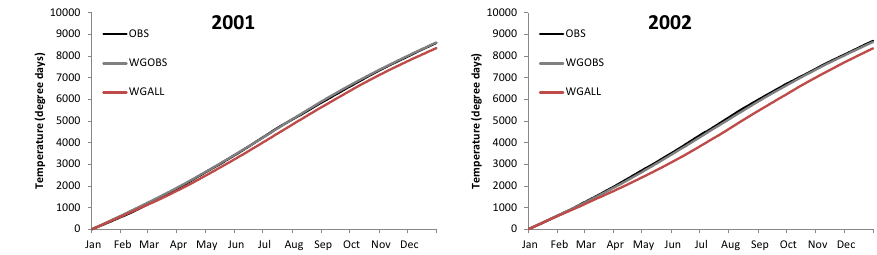
Figure 18 Observed (OBS) and generated (WGOBS, WGALL) cumulative degree day totals Fig. 17. Observed (OBS) and generated (WGOBS, WGALL) cumulative distributions of daily mean temperature (left) and precipitation for calendar years 2001 and 2002 at Taiz series (right) for years 1998–2005 at Taiz.